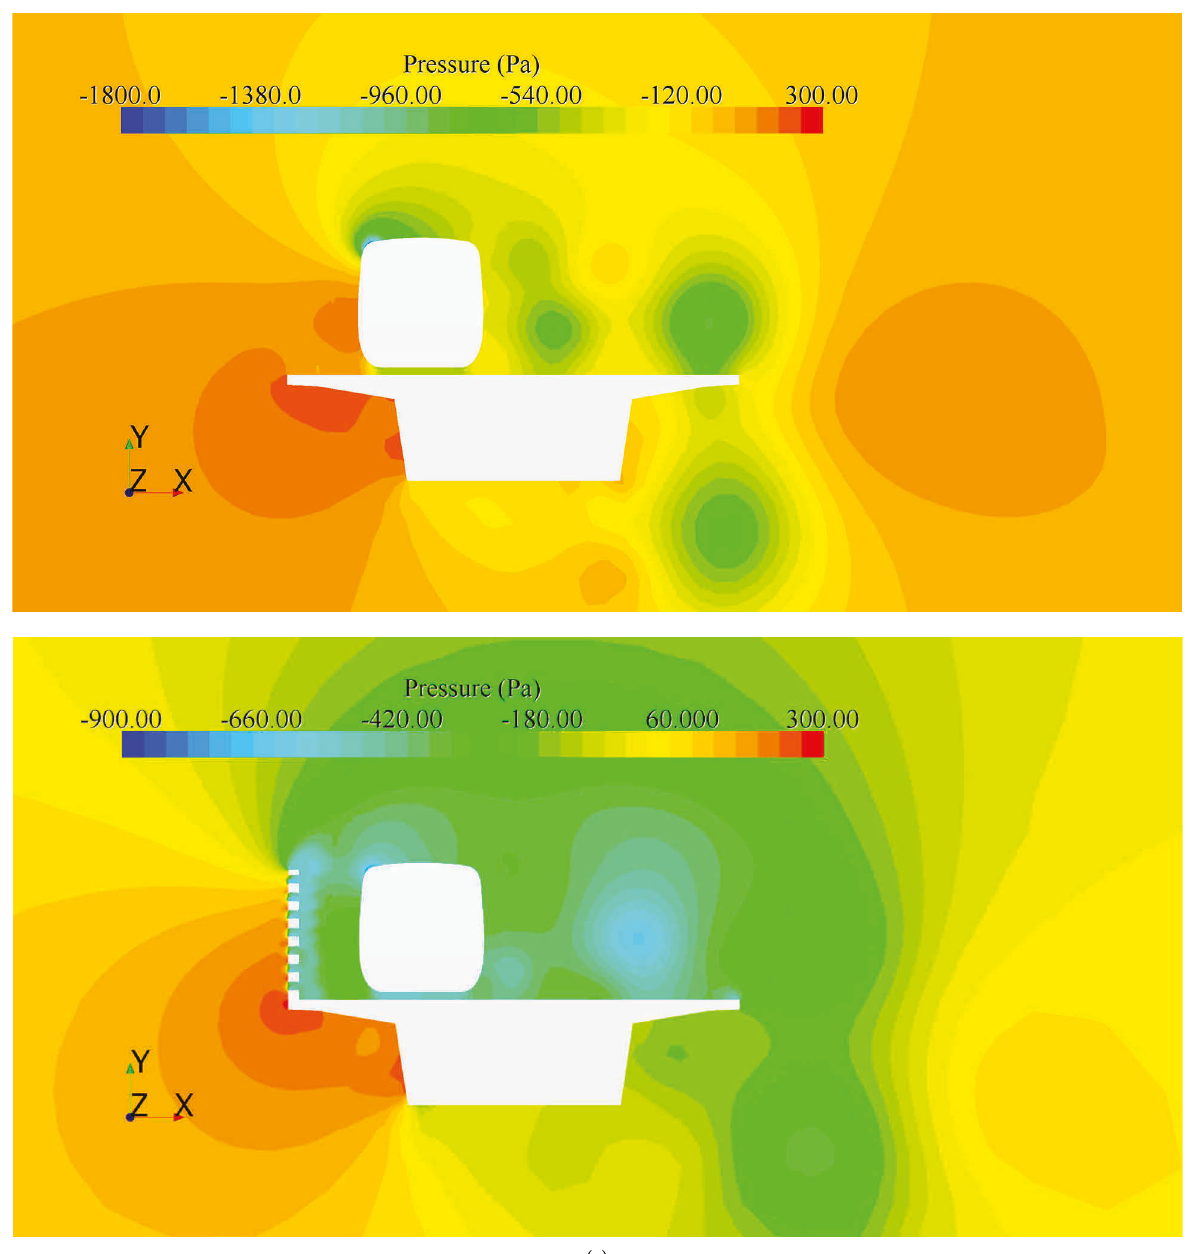
Figure 7: Pressure contour of the system with no/a wind barrier. (a) Head car. (b) Middle car. (c) Tail